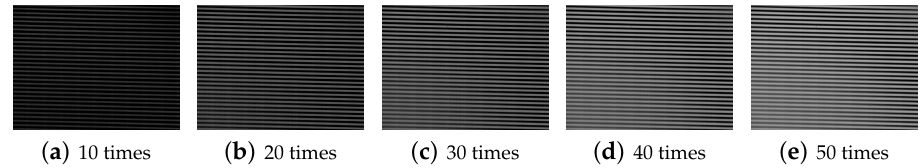
Figure 4. Measurement results of change in brightness depending on exposure times.